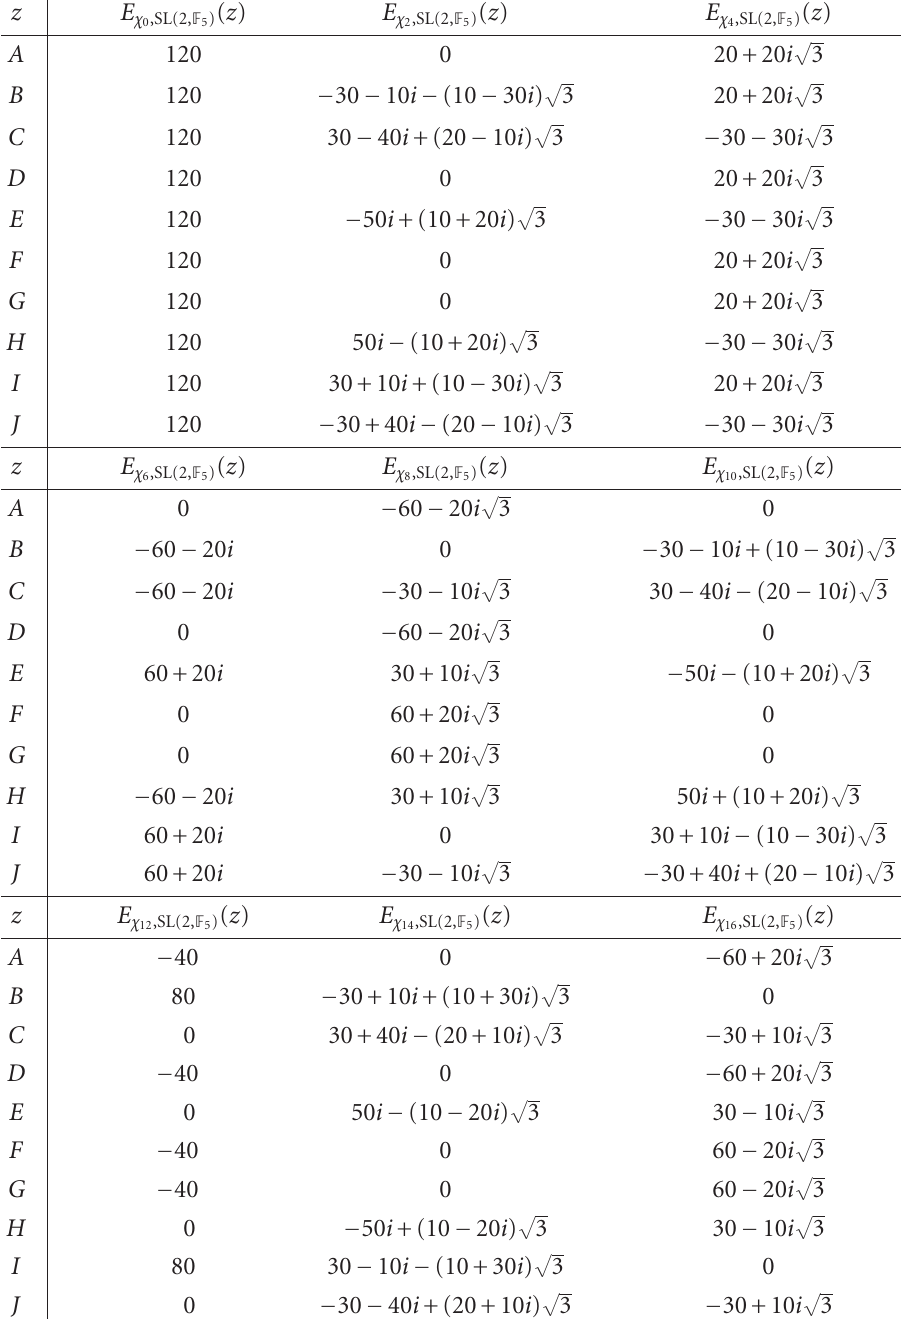
Table 2.2. Values of E χ , Γ on Γ \ H 25 for χ = χ a , 0 ≤ a ≤ 23, Γ = SL(2, F 5